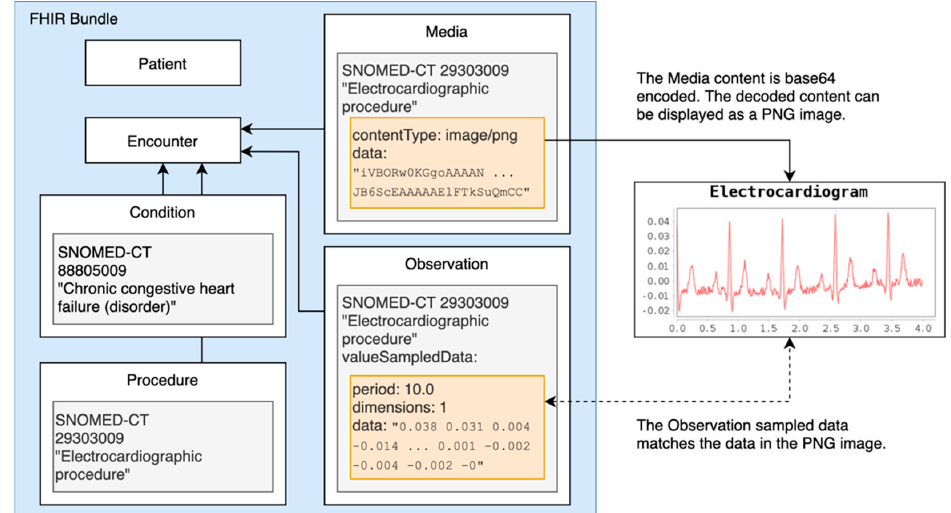
Figure 5. An electrocardiogram and associated observations are added to the synthetic health record of a patient. The relationships between the FHIR Resources and the ECG image are shown, where the image is a Base64 encoded PNG image included within the relevant FHIR Resources, as per the FHIR specification.